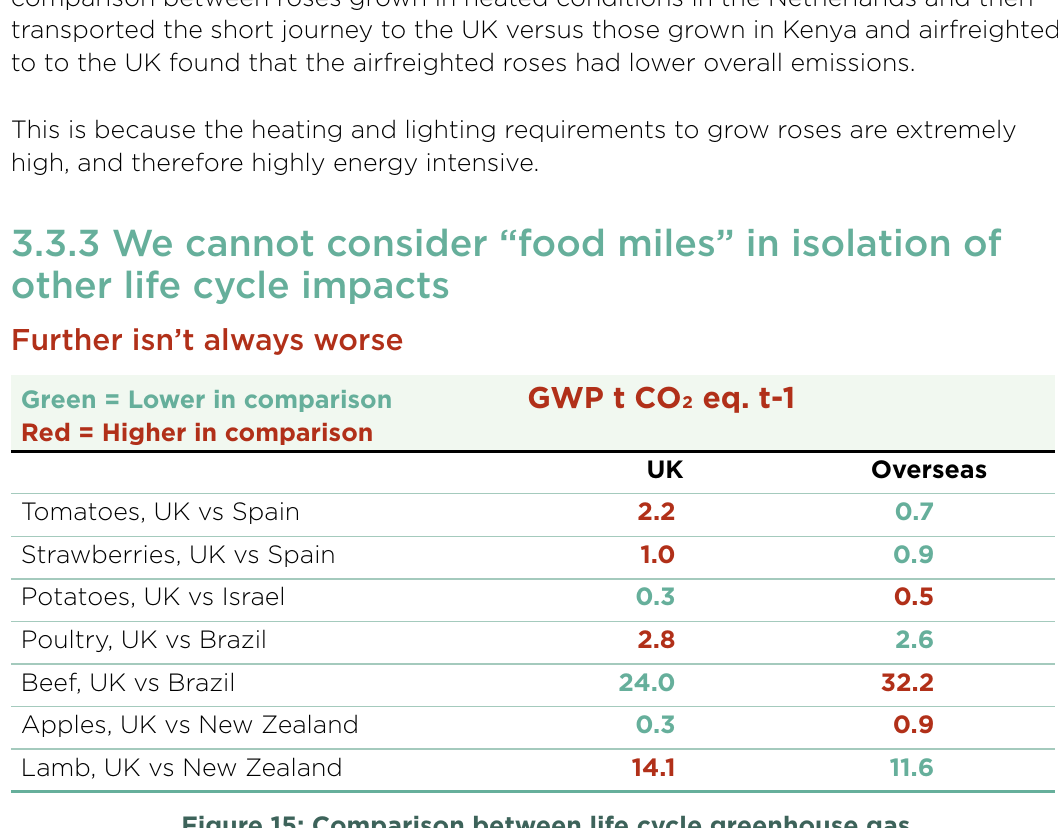
Figure 15: Comparison between life cycle greenhouse gas emissions of foods – air freighted vs. UK produced. Source: Webb, et al.